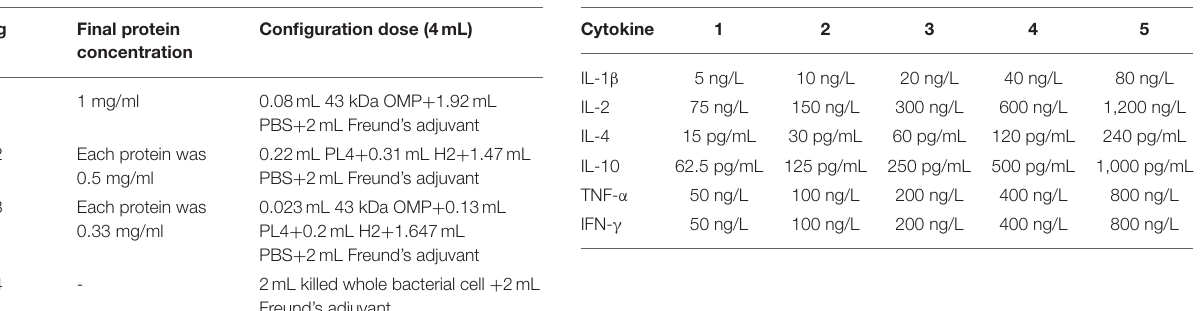
TABLE 2 | Standard sample dilution